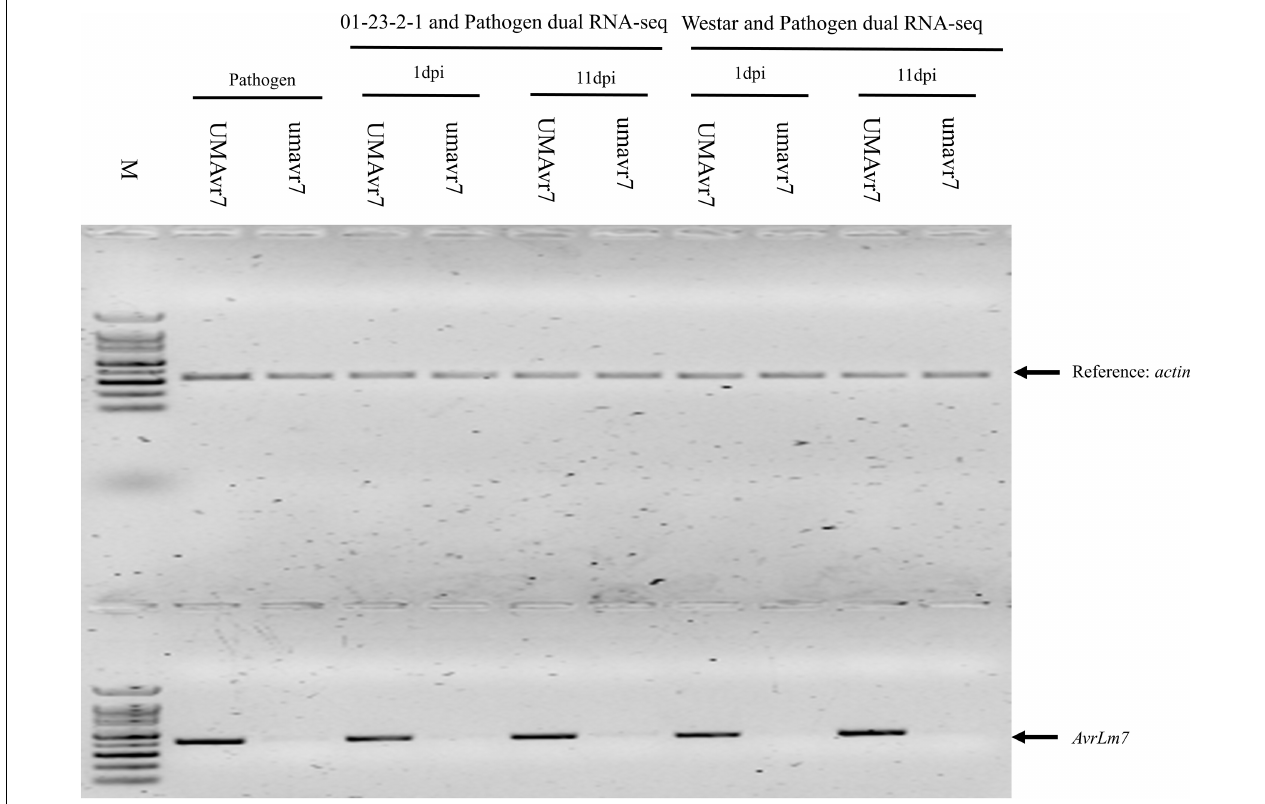
FIGURE 4 | Reverse transcription (RT)-PCR analysis of AvrLm7 gene in wild-type and mutant isolates only, and in Westar/01-23-2-1 genotypes inoculated with UMAvr7 and umavr7, respectively, at 1 dpi and 11 dpi. Leptosphaeria maculans actin was used as a control to quantify equal RNA